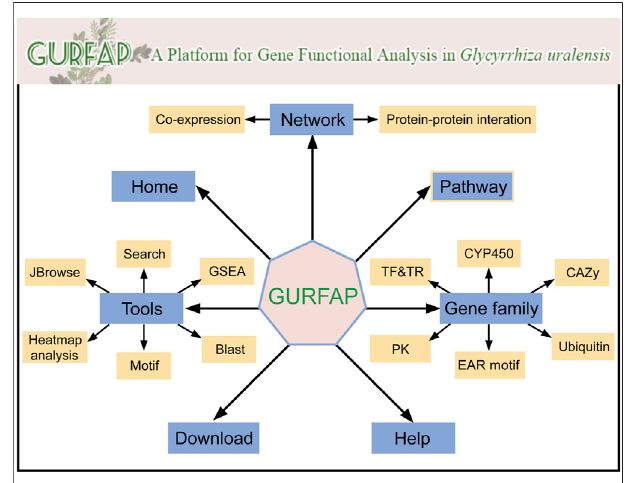
FIGURE2| OrganizationalchartforGURFAP.Networksectionprovides co-expression network and PPI network. The gene family section contains 6 different gene family classi fi cations. The tools section also contains 6 analysis tools. Home contains the introduction of G. uralensis and the platform. Pathway, Download and Help become a separate